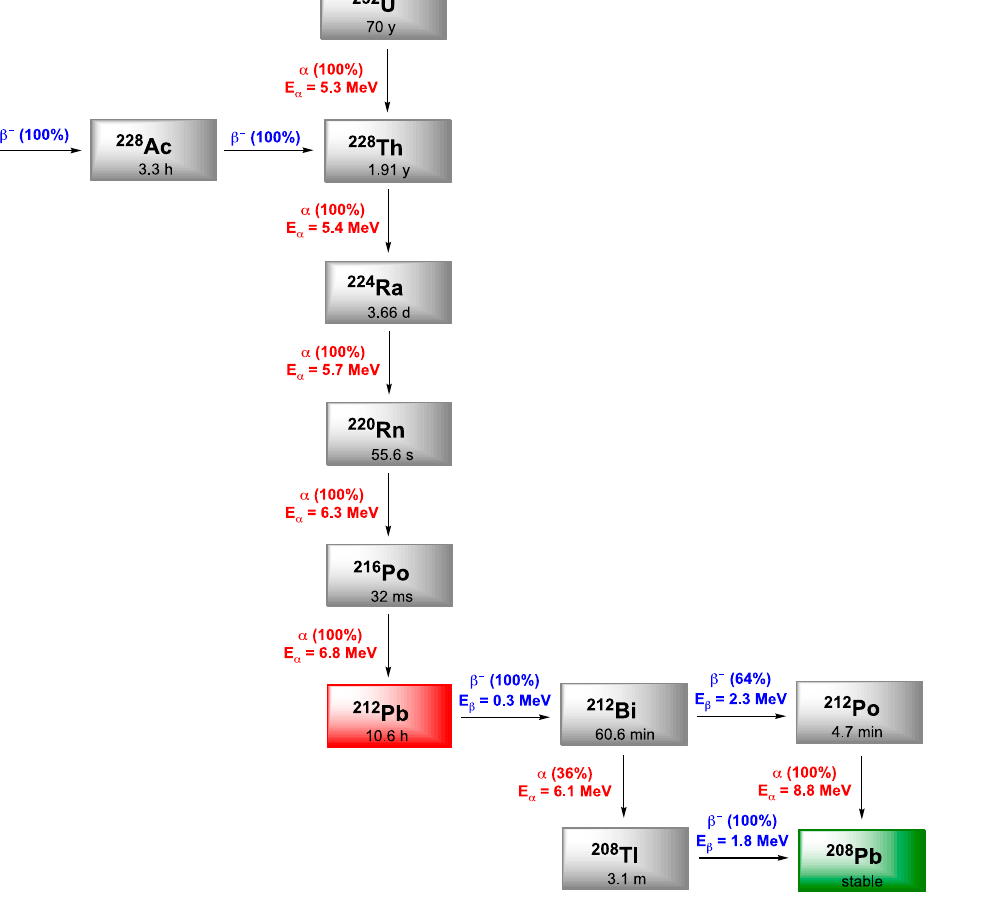
Figure 6. Decay schemes for the production of 212 Bi and 212 Pb.